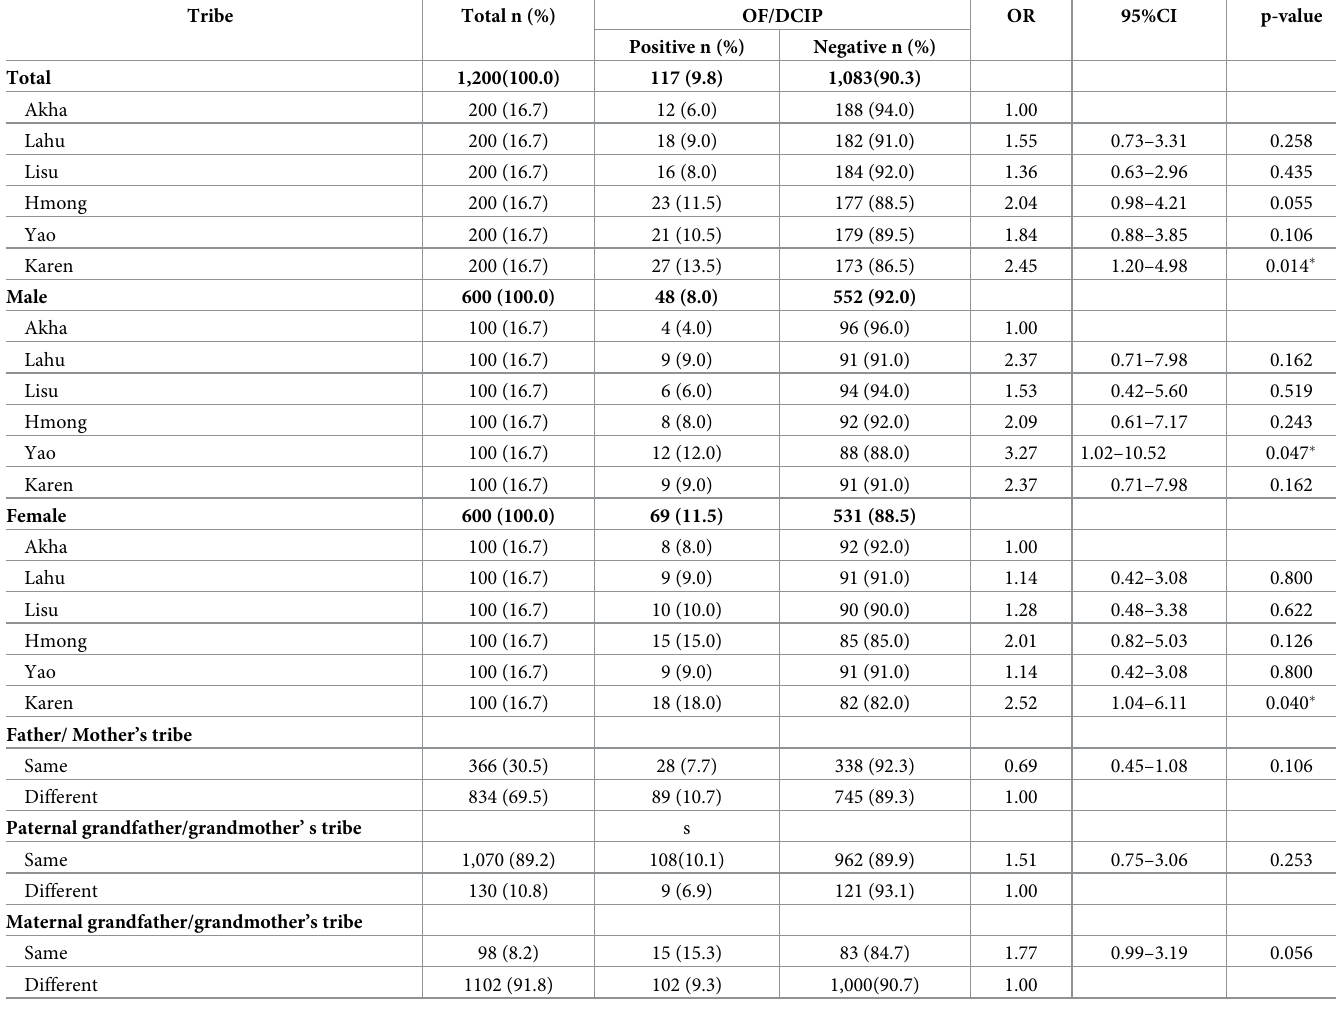
Table 8. Logistic regression analysis in identifying the associations between the difference of tribes and OF and/or DCIP positives.